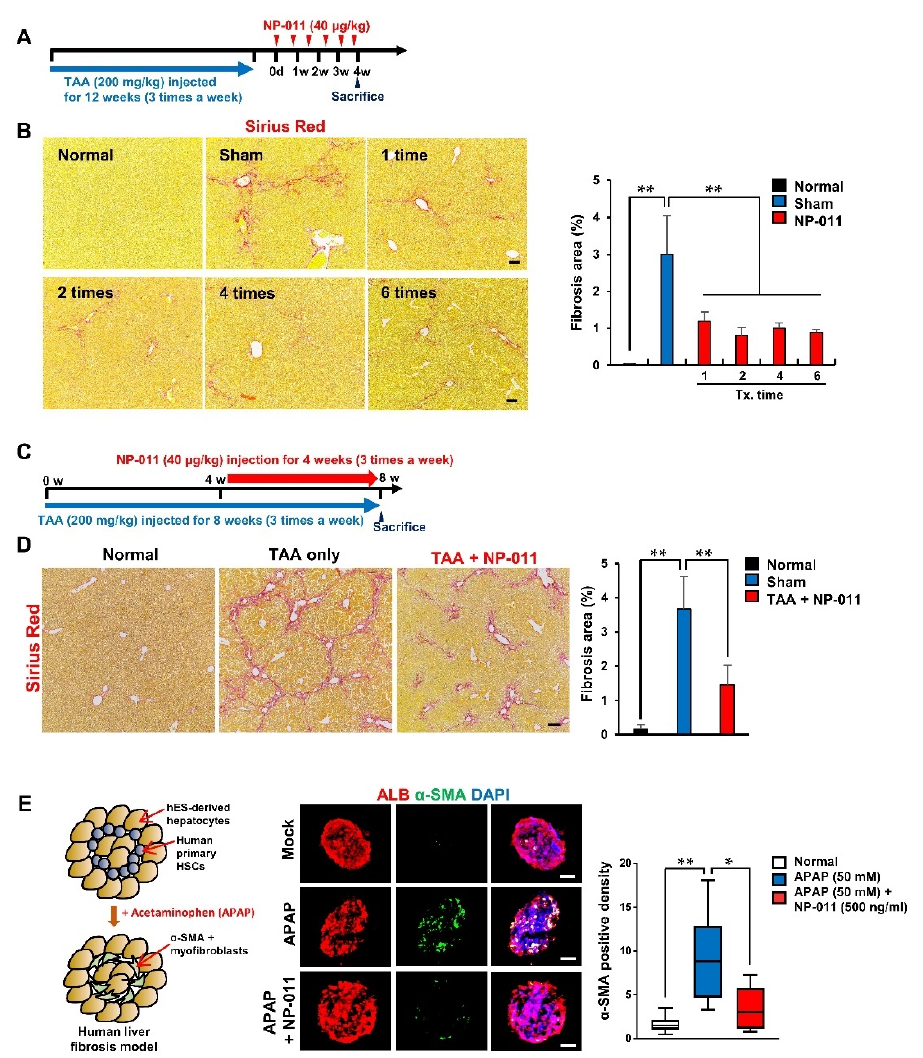
Figure 3. Therapeutic efficacy of a minimal effective dosage of NP-011 in various model inductions. ( A ) Overall schematic schedule for testing the efficacy of NP-011 in an advanced liver fibrosis model. The blue arrow indicates the period for TAA administrations for inducing liver fibrosis. ( B ) Repre- sentative images for analyzing fibrotic areas in livers of normal mice, a TAA-induced liver fibrosis model, and a 40 μ g/kg NP-011-administered liver fibrosis model with different numbers of administrations (1, 2, 4, and 6 times). Scale bar, 50 μ m. Quantitative analysis of fibrotic areas in the livers of normal mice, a TAA-induced liver fibrosis model, and a 40 μ g/kg NP-011-administered liver fibrosis model presented in the left panel. Bars represent the means ± SD from four mice in each group. ** p < 0.01, Student’s t -test. ( C ) Overall schematic schedule for testing the efficacy of NP-011 in a progressing liver fibrosis model. The blue arrow indicates the period for TAA administrations for inducing liver fibrosis. The red arrow indicates the period for NP-011 administrations. ( D ) Rep- resentative images for analyzing fibrotic areas in livers of normal mice, a TAA-induced liver fibrosis model, and a TAA-injected liver fibrosis model with co-administration of NP-011. Scale bar, 100 μ m. Quantitative analysis of fibrotic areas of livers in normal mice, a TAA-induced liver fibrosis model, and a TAA-injected liver fibrosis model with co-administration of NP-011 presented in ( D ). Bars represent the means ± SD from five mice in each group. ** p < 0.01, Student’s t -test. ( E ) Left panel: Graphical description representing a human liver fibrosis model using human embryonic stem cell (hESC)-derived hepatocytes and human primary HSCs treated with APAP. Middle panel: Repre- sentative images for analyzing hepatocytes and activated myofibroblasts with ALB (red) and α -